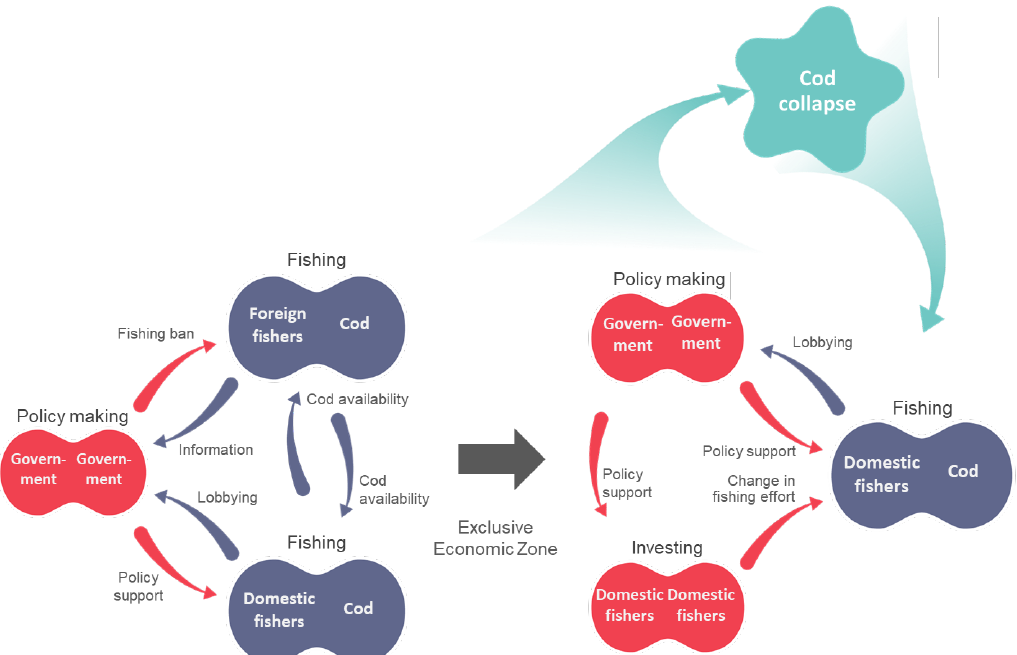
Figure A1: SE-AS representation of the configuration of social-ecological (dark blue) and social (red) action situations hypothesized to explain the collapse of the Newfoundland cod fishery